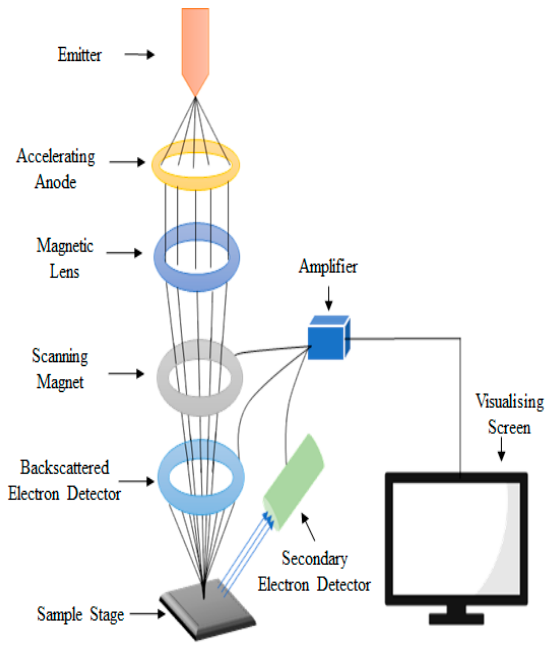
Figure 1. Scanning electron microscopy setup and its schematic diagram.